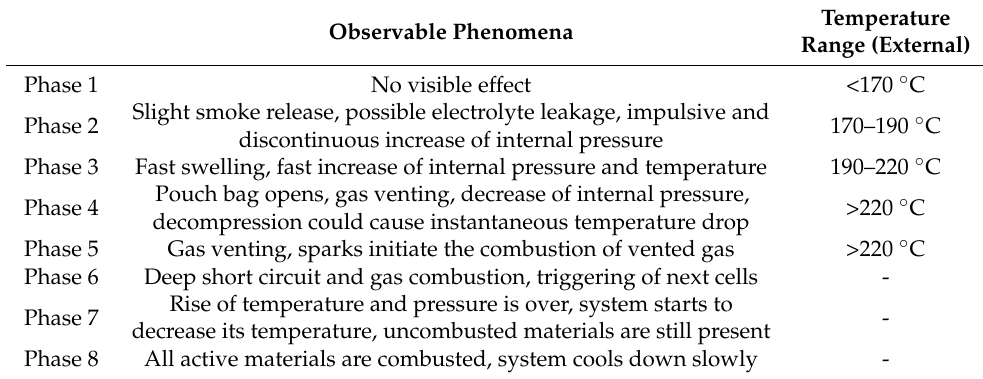
Temperature Range (External)